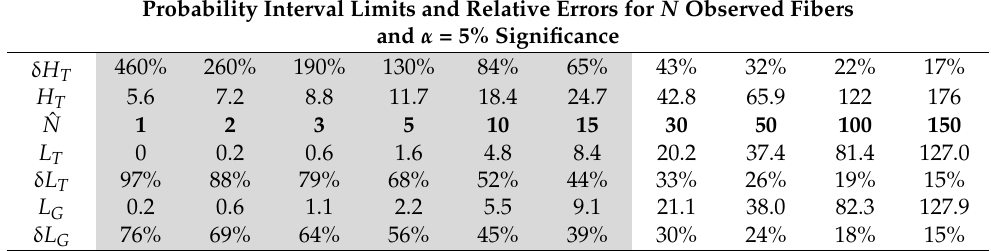
Table A2. Upper and lower limits of twin hypothesis testing for Frequentist ( L T and H T ) and Bayesian theorem ( L G ) probability intervals as calculated from Equations (A5), (A6) and (A12) for ˆ N observed fibers and a significance level of α = 5%. Gray areas indicate fiber counts with relatively large intervals. Probability Interval Limits and Relative Errors for ˆ N Observed Fibers and α = 5%